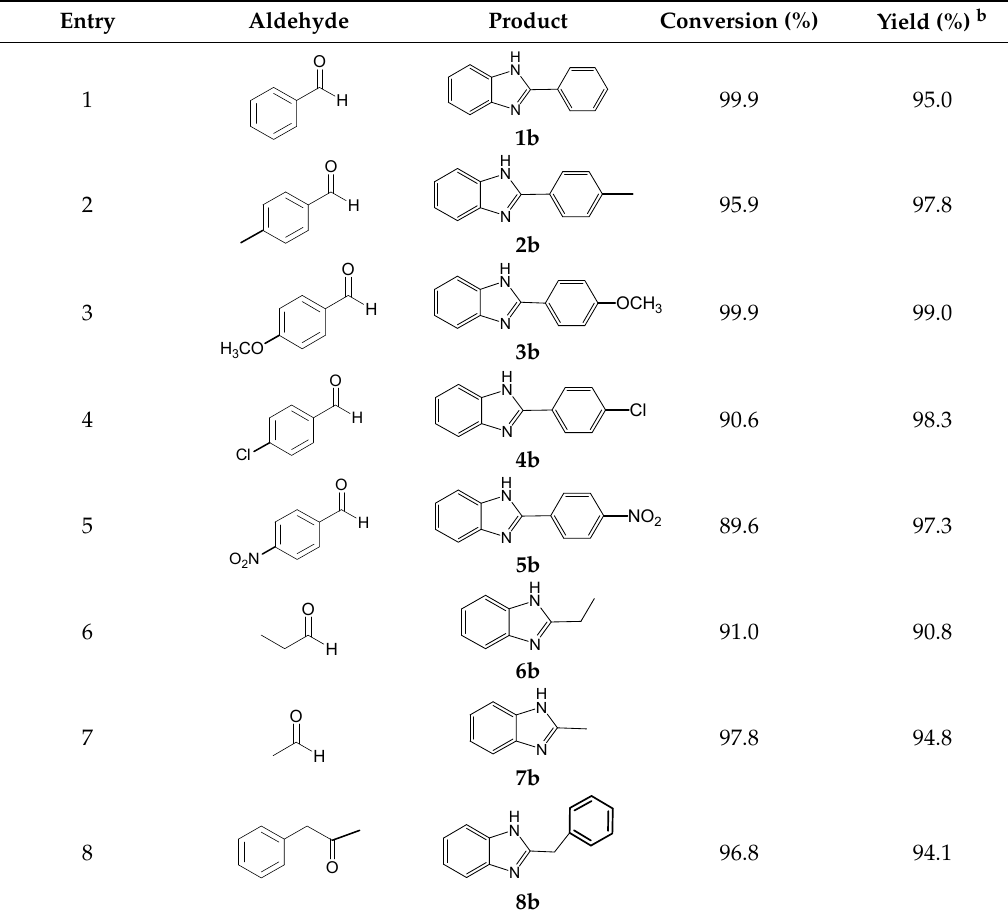
Table 3. Synthesis of 2-monosubstituted benzimidazoles. a